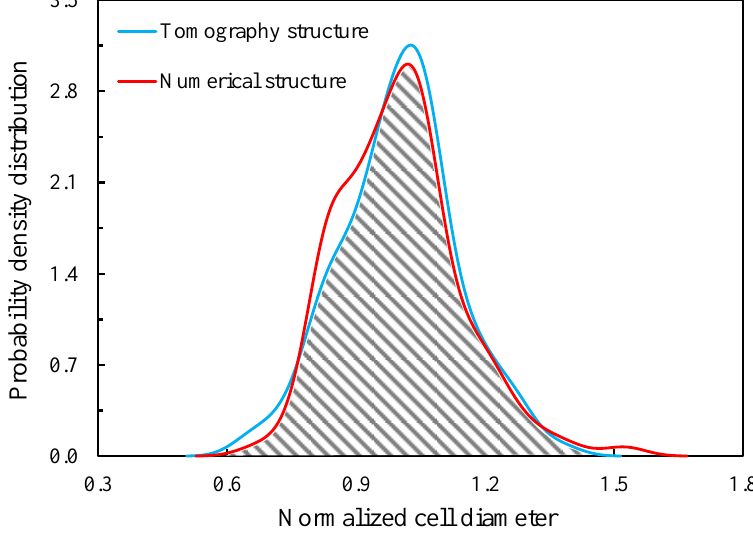
Figure 5. Normalized cell diameter distributions of the tomography structure and the numerical structure, as calculated by